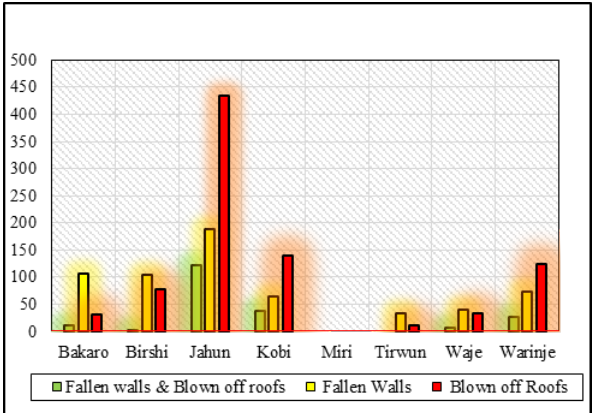
Figure 6. Damage Type by District